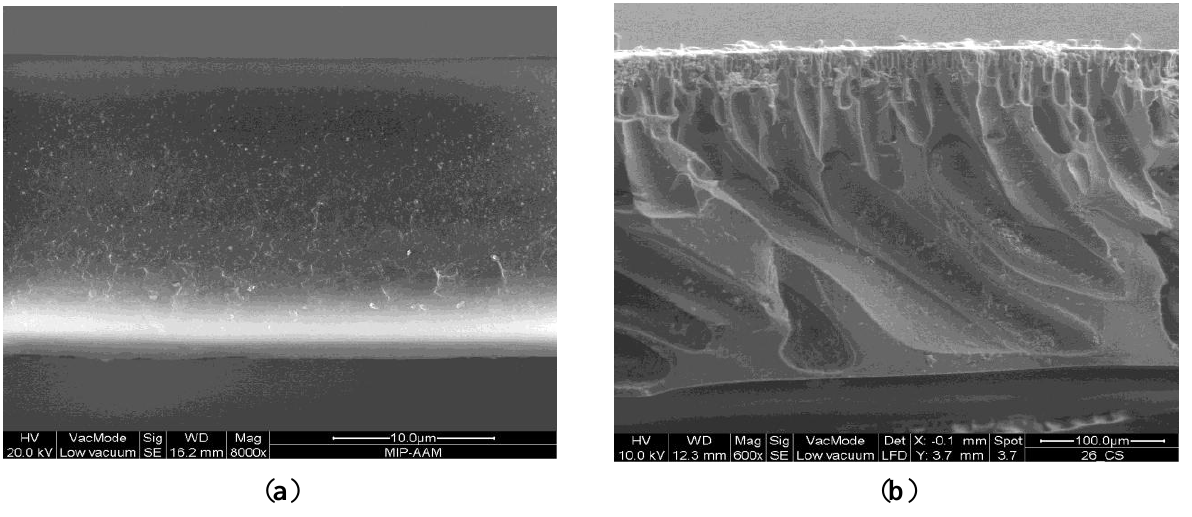
Figure 3. Cross-section of poly(co-acrylonitryle-co-acrylic acid membrane prepared via dry ( a ) and wet ( b ) phase